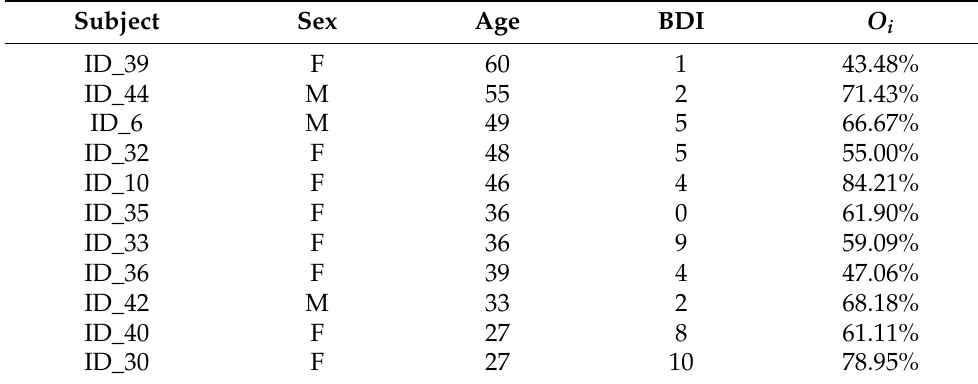
Table 5. Inversion percentages ( O i ) in non-depressed subjects.